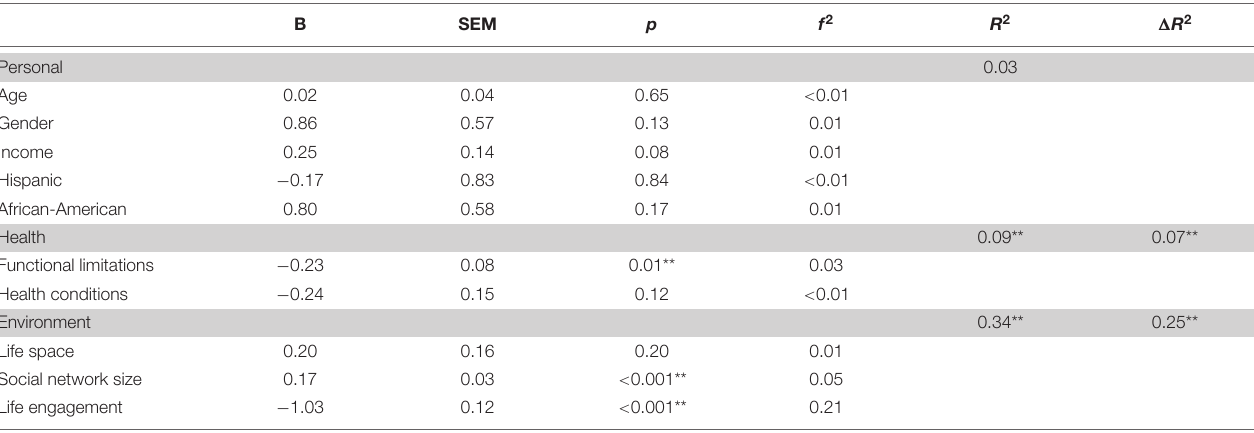
TABLE 8 | Results of hierarchical regression predicting social